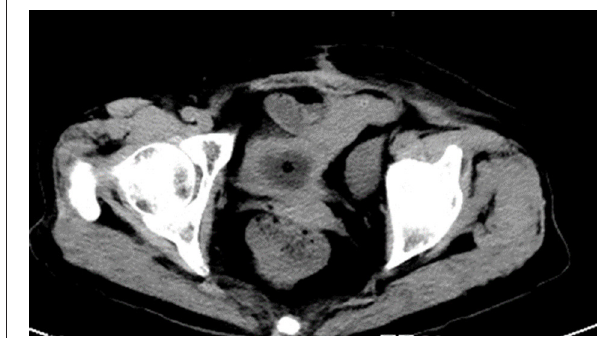
FIGURE 1 | Coronal section CT scan of case 1. The CT scan demonstrated an indwelling catheter in the bladder and a small amount of fluid collection in the abdominopelvic